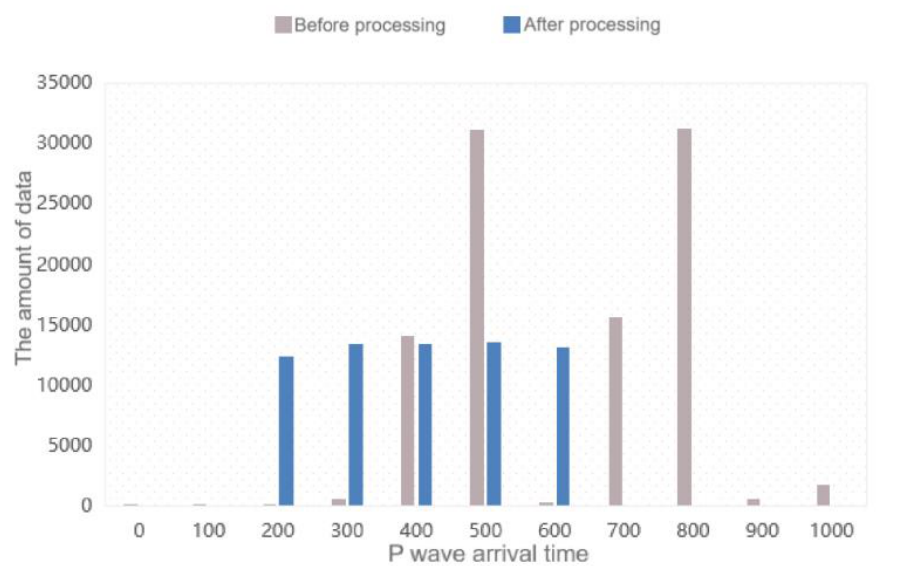
Figure 4. The data distributions before and after data processing (the gray bars show the data distribution before processing and the blue bars show the data distribution after